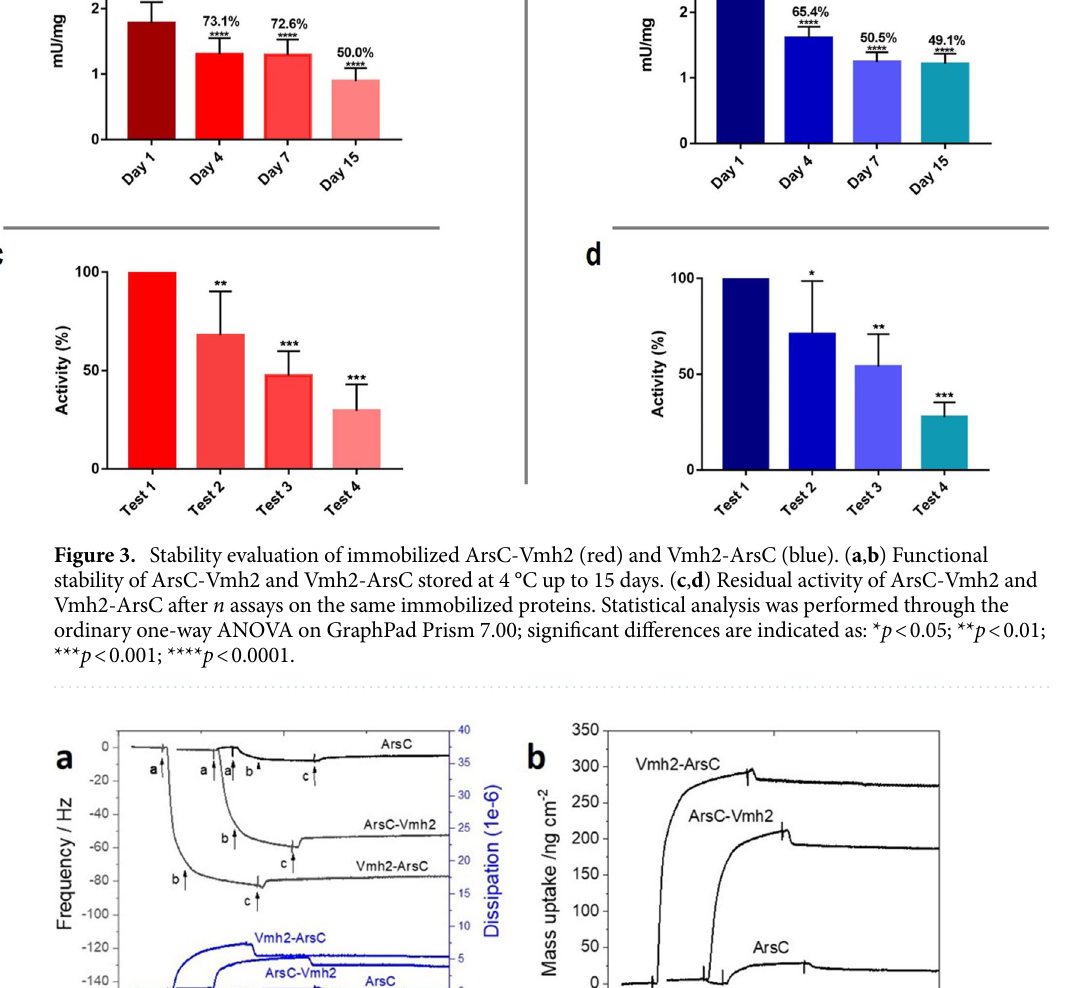
where C is the mass sensitivity; C = 17.7 ng cm −2 Hz −1 at f 1 = 5 MHz and n is the accordant overtone number. Curves for each overtone show an average mass of immobilized ArsC-Vmh2 and Vmh2-ArsC of 187 ± 22 and 275 ± 5 ng cm −2 respectively. Considering a 50% degree of hydration for the enzyme layer 59 , this would corre- spond to a ArsC-Vmh2 and Vmh2-ArsC surface density of 4.3 and 6.4 pmol cm −2 respectively. As expected, a of immobilized enzymes, it is also noteworthy that, according to the initial mass uptake evolution, an initial rate of deposition of 2.4 and 1.0 pmol cm −2 min −1 was measured for Vmh2-ArsC and ArsC-Vmh2 respectively. This rate is almost ten-times higher compared to the simple adsorption of the native enzyme (0.25 pmol cm −2 min −1 ), hypothesizing that Tt ArsC, Vmh2-ArsC and ArsC-Vmh2 might have the same flow rate into the cell. Electrochemical As(III) biosensor.